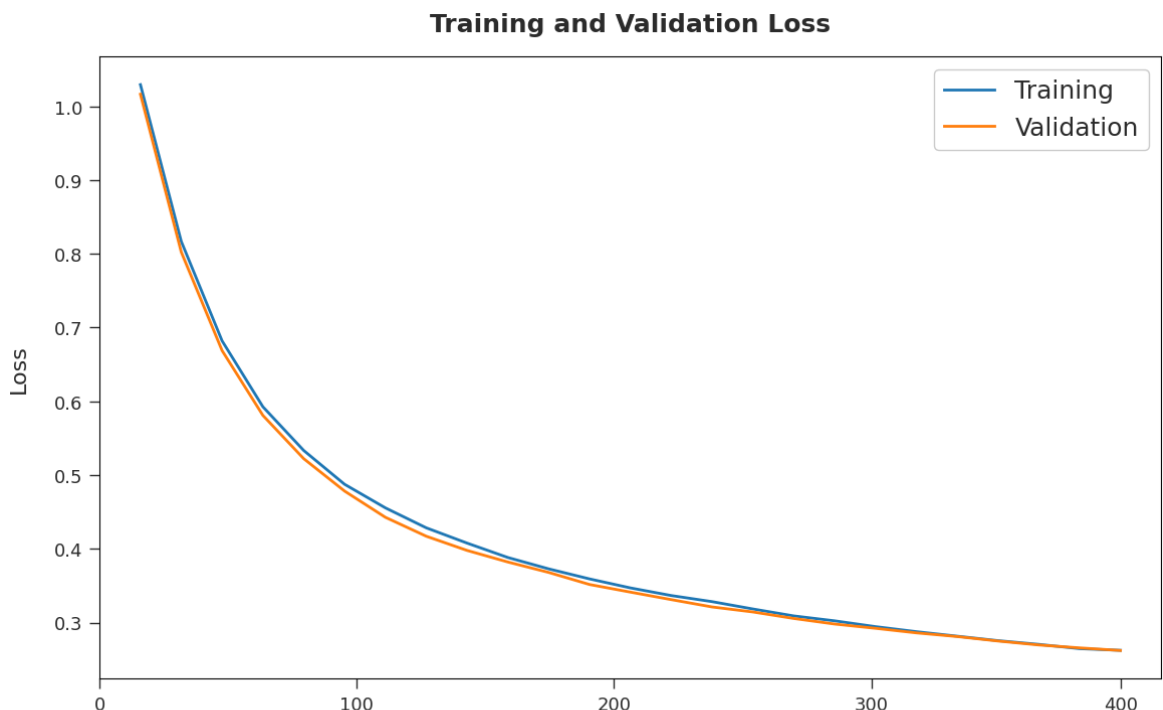
Figure 8. TL and VL analysis of MDTL-ICDDC technique.